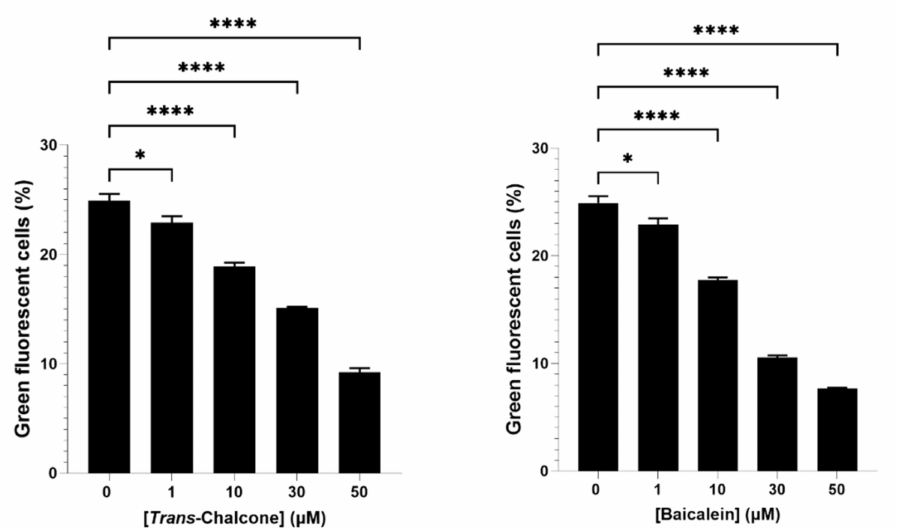
Figure 2. Population of BY4743 ∆ ahp1 [p416.GPD.GFPA β 42 ] with green fluorescence following exposure to trans -chalcone (left panel) and baicalein (right panel). Statistically significant values obtained from one-way ANOVA test in reference to untreated control are represented by asterisks (* p < 0.05 and **** p < 0.0001).